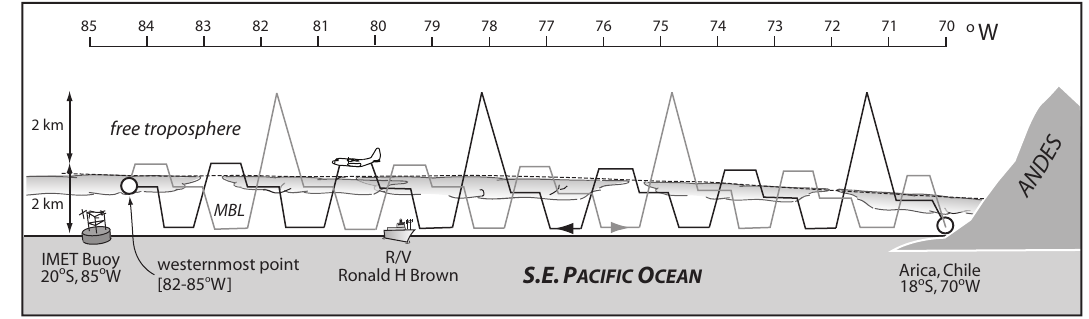
Fig. 4. The NCAR C-130 flight plan along 20 ◦ S, with the outward leg in black and return leg in grey. Figure provided by Robert Wood, see Wood et al. (2011b) for more information on flight plans and aircraft